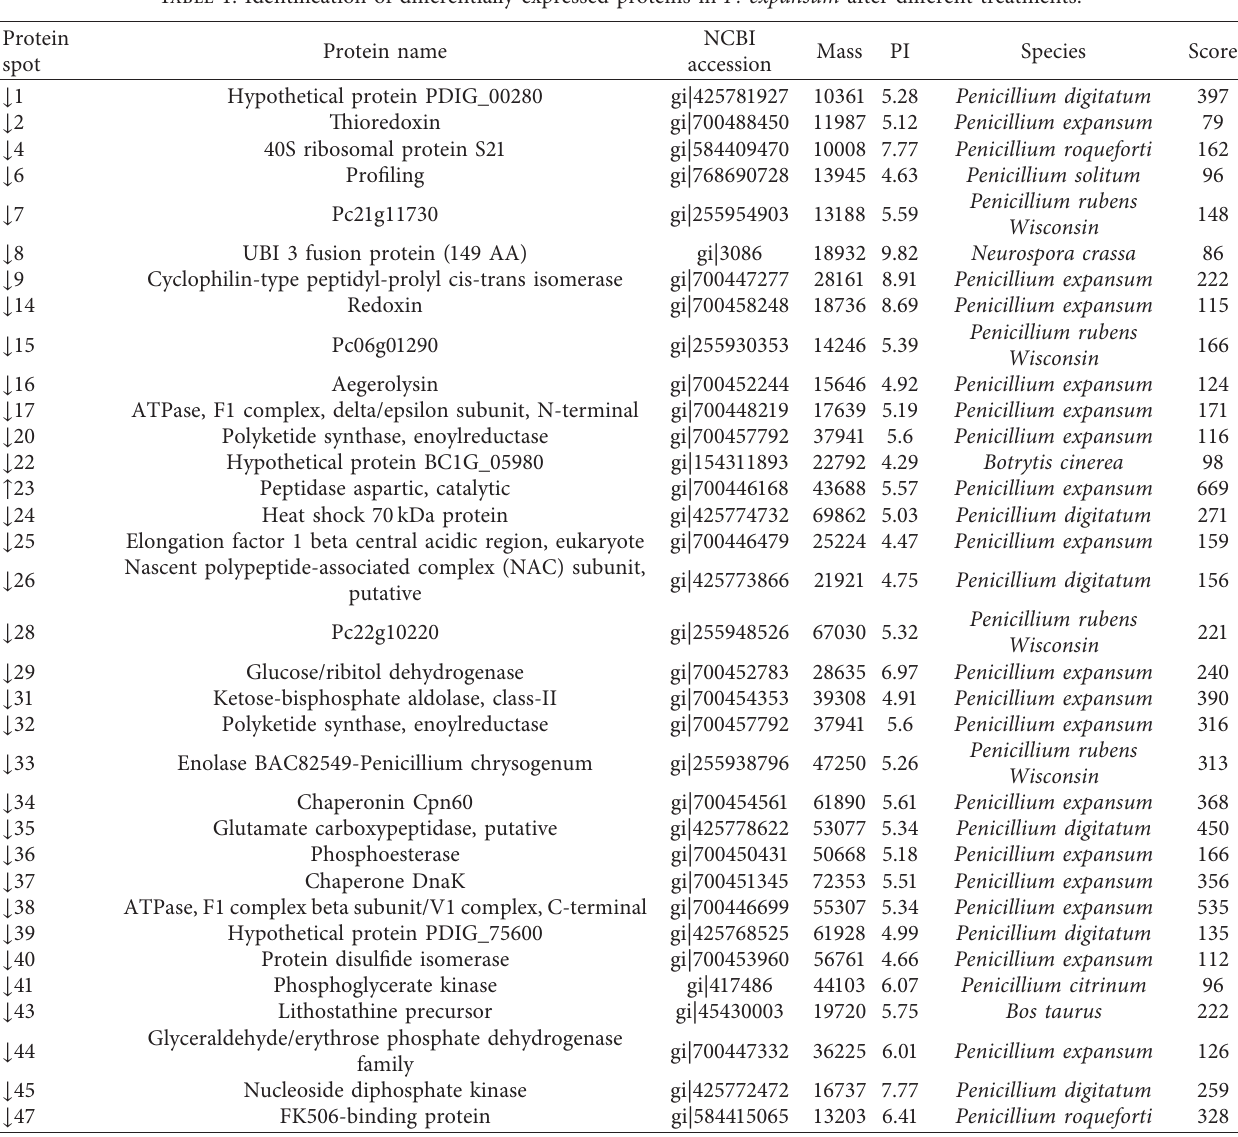
Table 1: Identification of differentially expressed proteins in P. expansum after different treatments. Protein